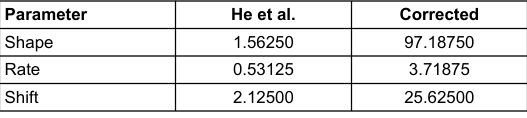
Figure 2: Using the maximum likelihood estimates of the infectivity profile from figure 1, we reconstructed the serial interval. We sam- pled 10 6 infection times from the infectivity profile and added this to samples from the log-normally distributed incubation period to generate samples of the serial interval. We then plotted the proba- bility density of these serial intervals (density profiles). We com- pared this to the serial interval data used in He et al. [1], where we have added points for each day in the possible serial interval range.